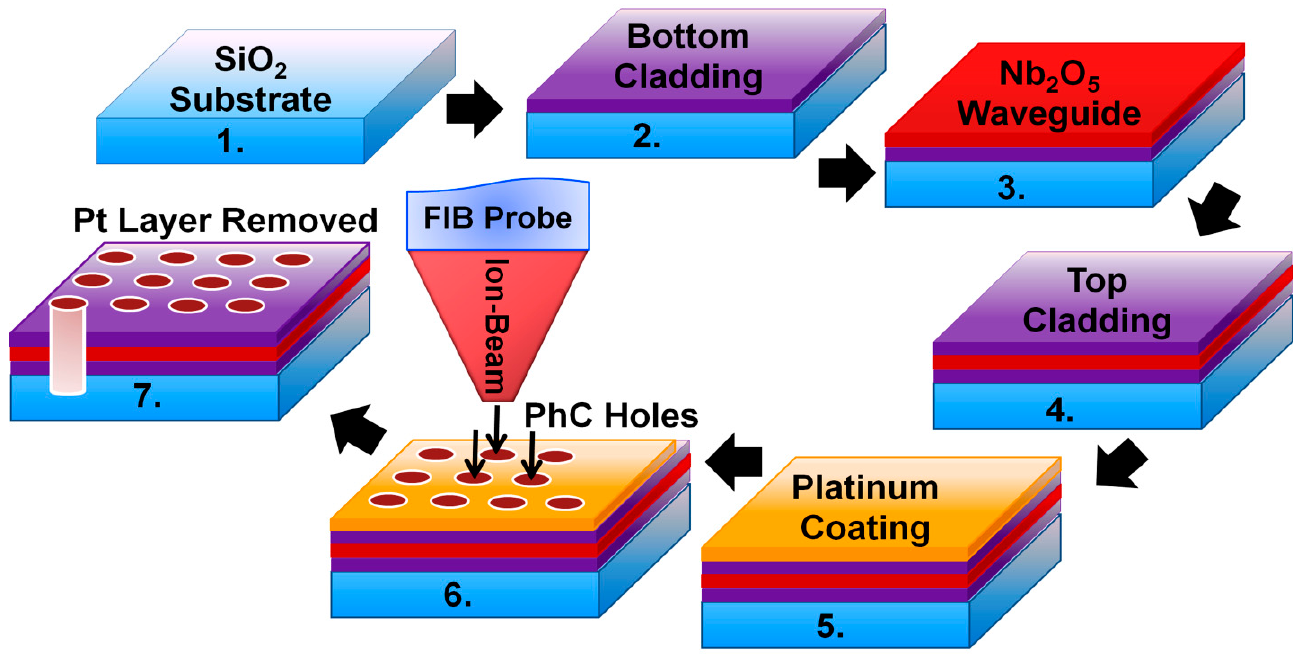
Figure 1. Experimental procedure for the fabrication of a dielectric PhC nanosensor device.